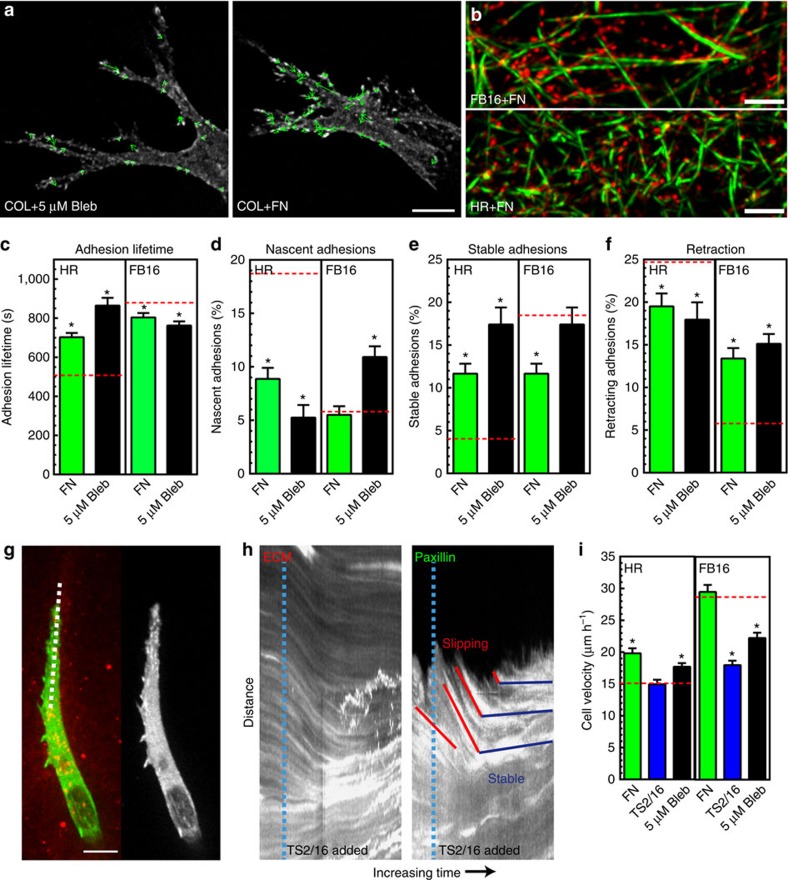
Balancing cytoskeletal tension with ECM/adhesion coupling is required for efficient 3D migration.(a) Adhesion movements in HR collagen+5 μM blebbistatin (Bleb; left) and HR collagen+FN (right). (b) SIM images of 300 μg ml−1 fibronectin (red) associated with FB16 or HR collagen fibrils (green). (c–f) Treatment of collagen with HPFN or reducing contractility with 5 μM blebbistatin has differential ECM-dependent effects on adhesion lifetime (c) nascent (d) and stable adhesions (e) and the population of retracting adhesions (f). Dashed red lines in (c–f) indicate untreated control levels (DMSO, IgG). N≥3, n≥400. (g,h) Integrin activation (TS2/16; 2 μg ml−1) stabilizes adhesions. Kymographs ((g) dashed white line) show adhesion slippage and retraction (red lines) until the addition of TS2/16 antibody (dashed cyan lines in h). Antibody treatment activates integrins for ECM gripping and results in adhesion stabilization (horizontal blue lines). (i) Migration of HPFN, TS2/16, or 5 μM blebbistatin treated cells compared with controls N=3, n>48 (dashed red lines).* Significantly different from control ECM; P<0.05 (ANOVA). Errors bars: s.e.m. Scale bars: (a) 2 μm; (b,g) 10 μm.